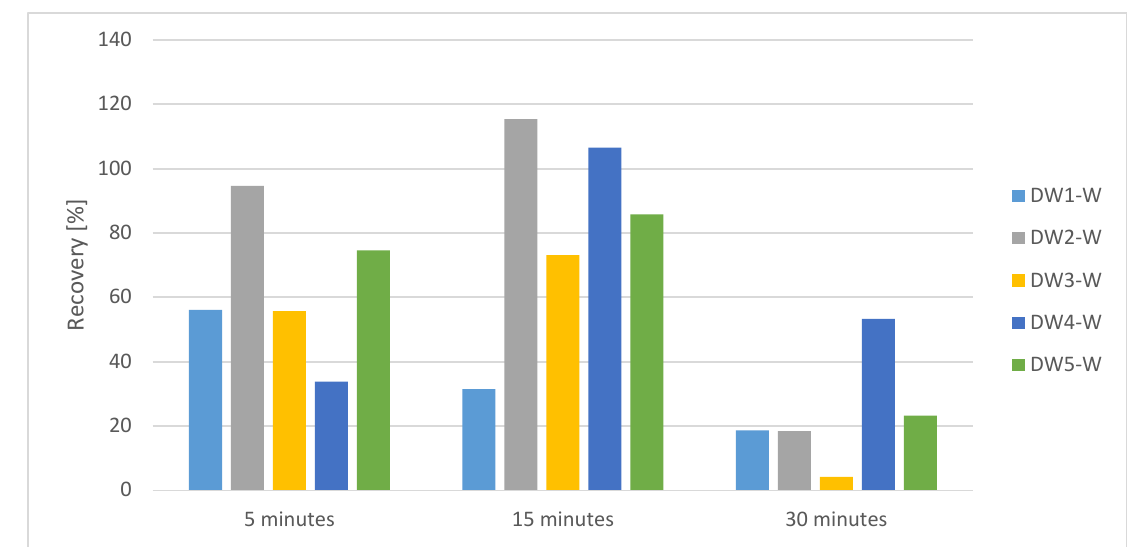
Figure 9. Recovery calculated from Ag concentration for three different centrifugation times (5 min, 15 min, and 30 min) in DW(1-5)-W drilling waste water extract samples with AgNPs (60 nm).